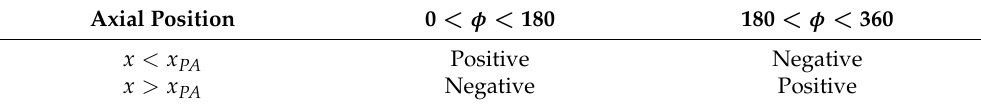
Table 1. Relationship between phase of the unsteady pressure on the suction side and work input. x PA is the axial coordinate of the pitching axis. Positive work input is